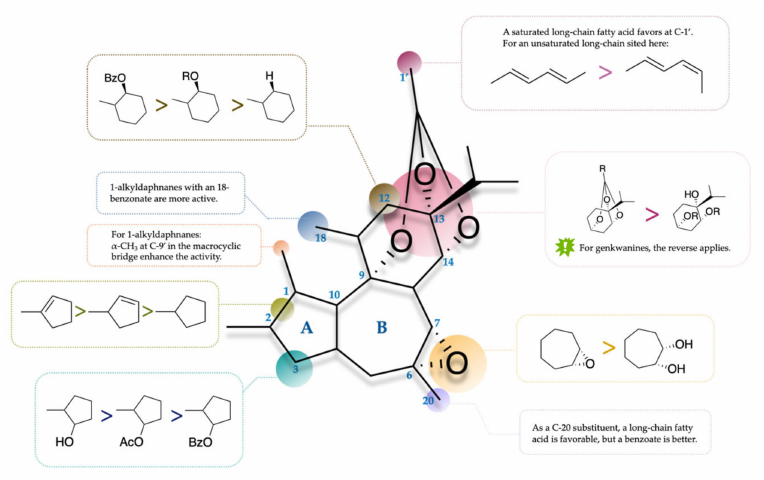
Figure 10. SAR of diterpenoids as antineoplastics. SAR in the Ring